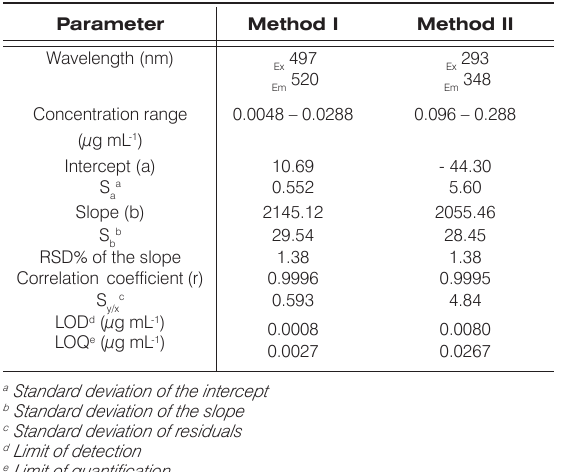
Table 1. Analytical parameters for the determination of penicillamine using the proposed methods.